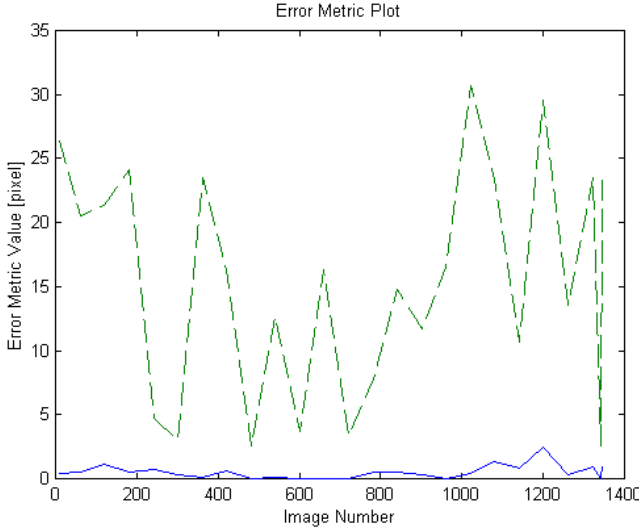
Figure 9. Plot of matching error metrics as a target object rotates in 3D space. (The Sylvester video given in Figure 8 was used as the selected target object for this